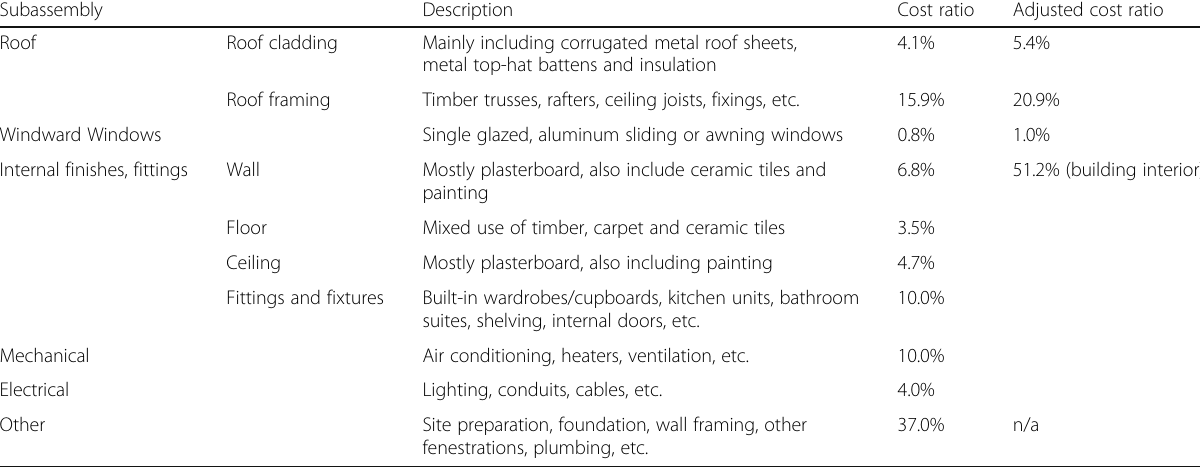
Table 4 Subassembly cost ratios for the representative contemporary house Subassembly